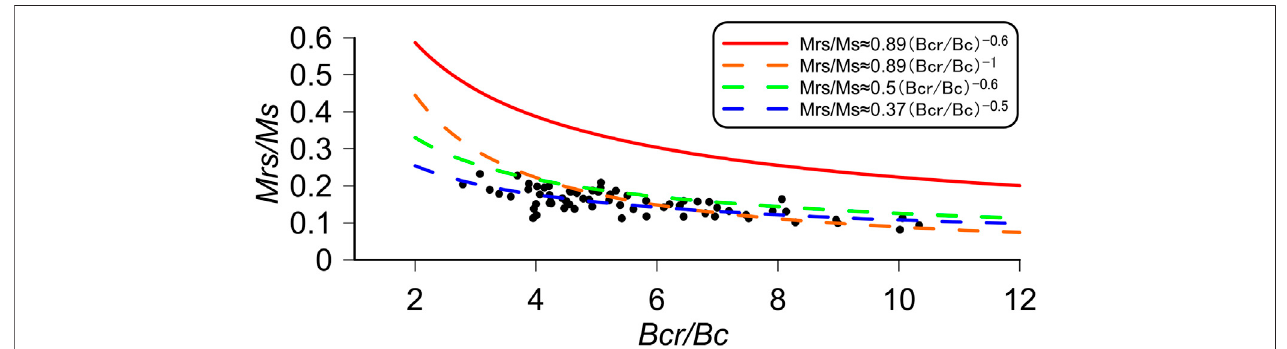
FIGURE 10 | Hysteresis parameters for the Upper limestone ZD Formation in the SLC section and empirically derived model of remagnetized carbonates. The red linerepresentstheequationfromJacksonandRochette(1993);theorangeandgreendottedlinesrepresentthemodi fi edequationsofJacksonandRochette(1993);the blue dotted line represents the best fi t equation of our data.